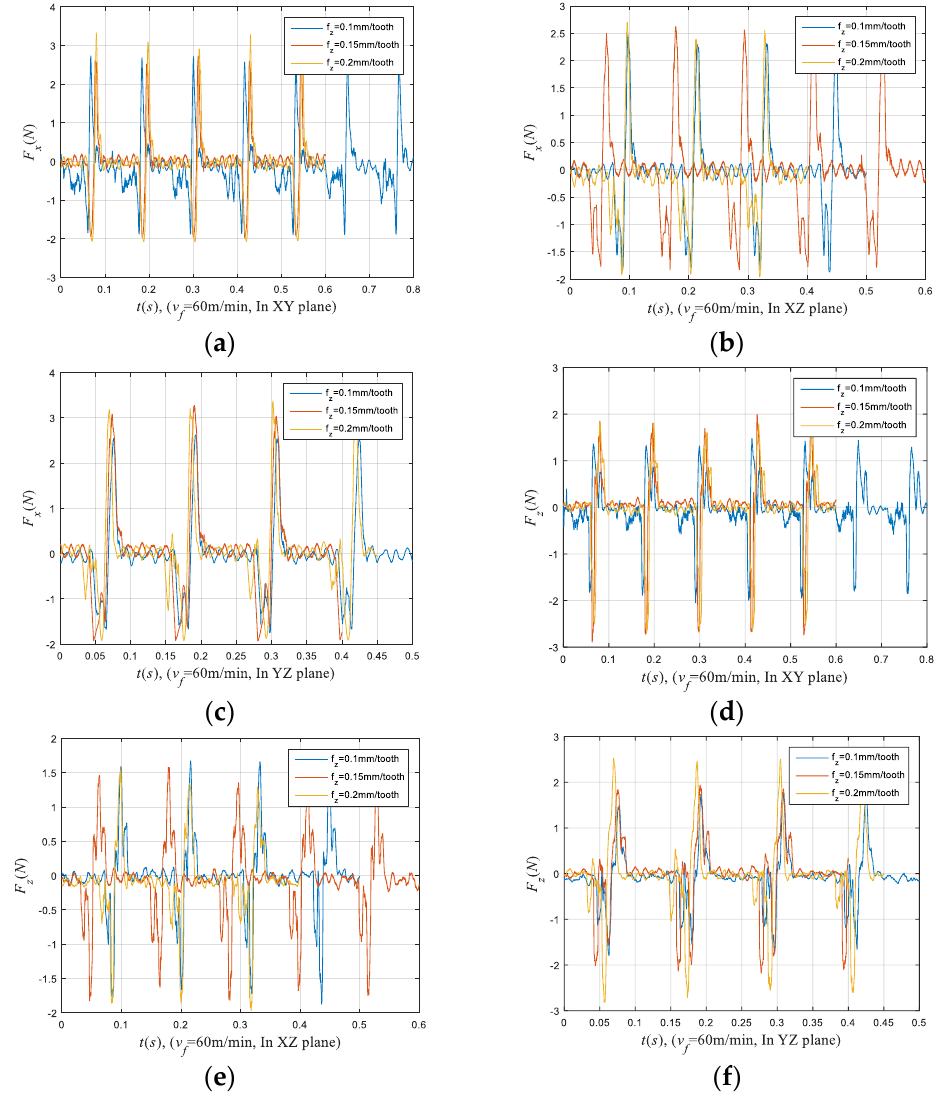
Figure 5. The influence of feed rate on milling forces in F x without normalization: ( a ) Case 1 (milling in XY plane), ( b ) Case 2 (milling in XZ plane), ( c ) Case 3 (milling in YZ plane) and milling forces in F z without normalization: ( d ) Case 1, ( e ) Case 2, ( f ) Case 3 for the workpiece built with SSR of 90°.